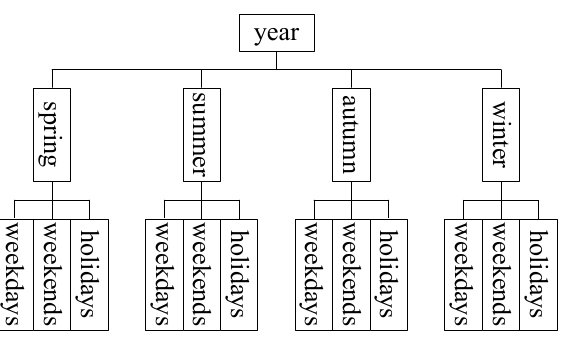
Figure 5. Schematic diagram of the classification of daily load